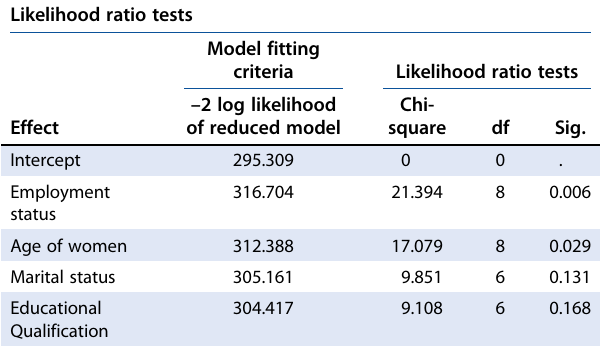
Table 4: Multinomial logistic regression analysis tests Likelihood ratio tests